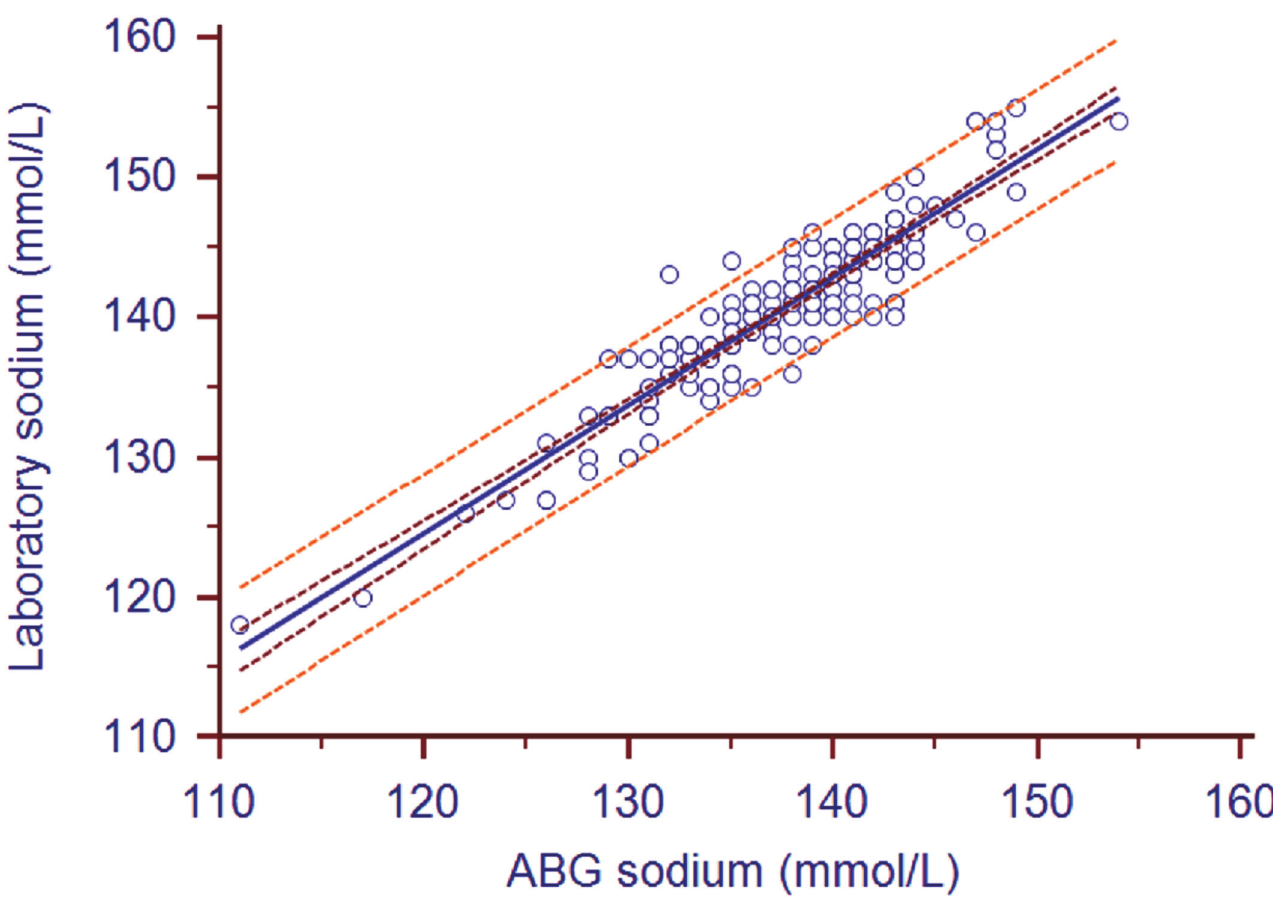
Fig 4. Sodium scatter plot with Deming fit. Concordance plot shows agreement between laboratory- and ABG-measured sodium (in mmol/L). The solid line indicates the correlation coefficient (r = 0.92). The brown line indicates the 95%CI of correlation coefficient (0.9 to 0.94). The orange line indicates the